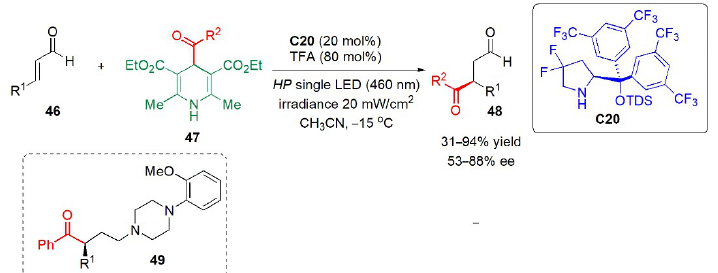
Figure 17. Enantioselective synthesis of 1,4-dicarbonyl compounds via acyl radical conjugate addition to chiral imines derived from enals [86]. In 2019, an enantioselective radical addition method using vinyl pyridines to prepare γ-functionalized pyridines was described. It relied on asymmetric cooperative photore- dox catalysis mediated by visible light (Figure 18) [87]. Prior to this report, methods to functionalize vinyl pyridines at either the α-position [88,89] or the β-position [90] using Brønsted acid organocatalysis in combination with photoredox catalysis were known.